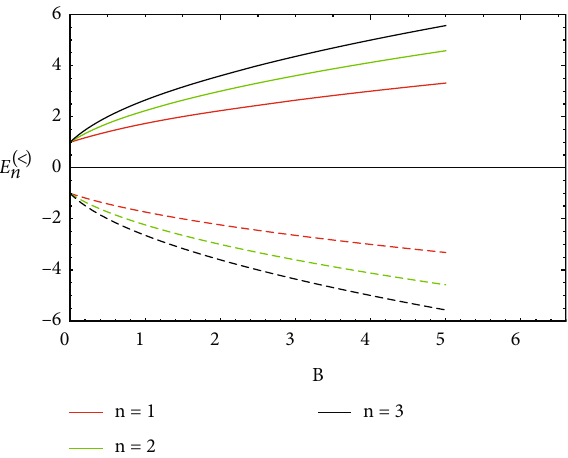
(Equation (70)) as a n